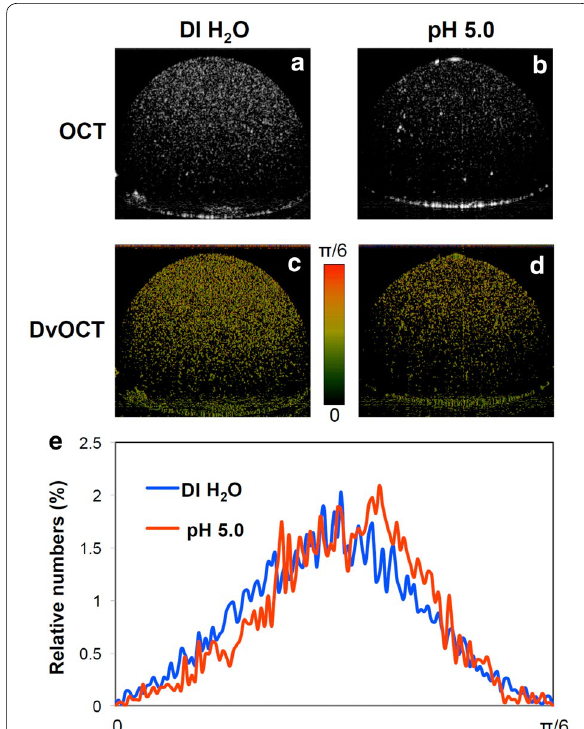
Fig. 4 Acid‑disassembly of Au NCs observed by OCT and DvOCT. Images of acid‑disassembling Au NCs in droplets (3 μL) obtained using SD‑OCT ( a , b ) and DvOCT ( c , d ) after incubation in DI water or pH 5.0 acetate buffer at 37°C for 2 h. Fast and slow moving particles ( c , d ) were color‑coded with red and green, respectively, and further